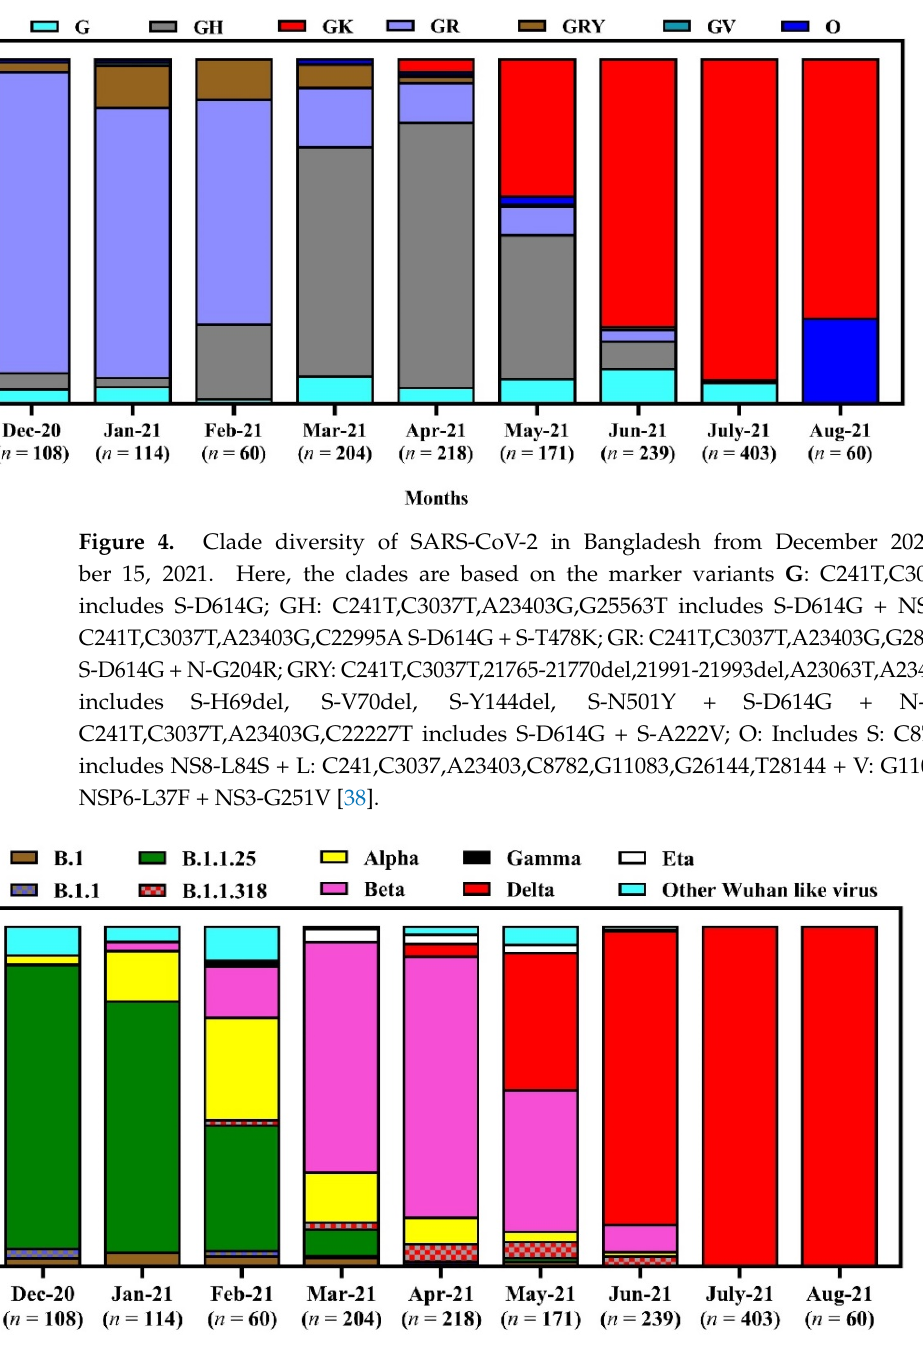
Figure 5. Lineage diversity of SARS-CoV-2 in Bangladesh from December 2020 to 15 September 2021.